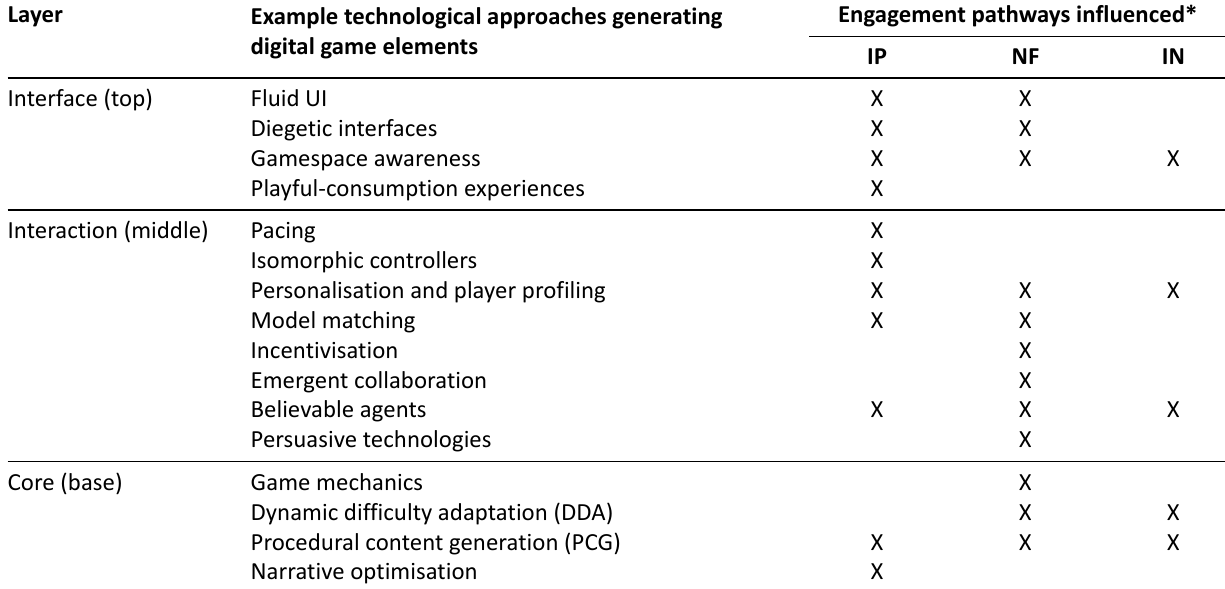
Table 1. The proposed framework.